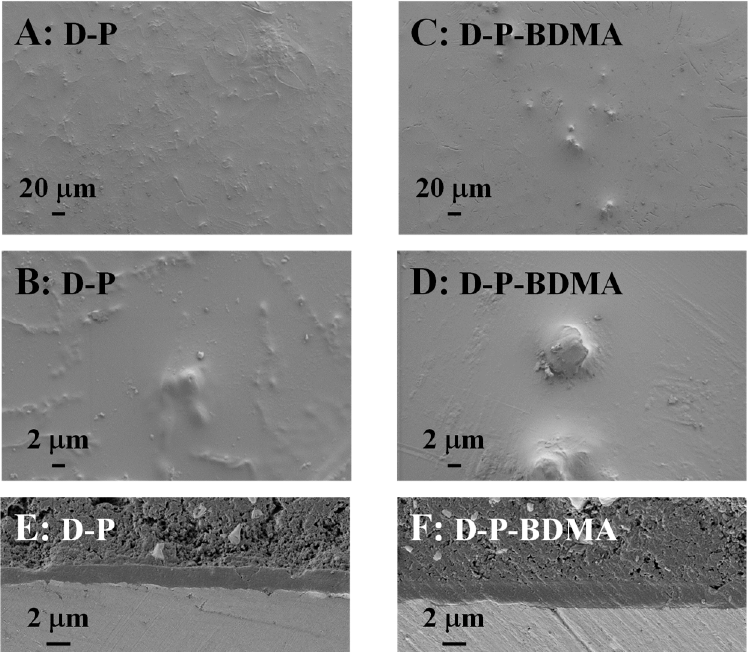
Figure 10. SEM micrographs of protective coatings at di ff erent magnifications: ( A , B ) D-P coating and ( C , D ) D-P-BDMA coatings. ( E , F ) Cross-cut SEM micrographs of D-P ( E ) and D-P-BDMA ( F ) coatings. Table 3. Morphological and electrochemical characterization of the protective coatings.